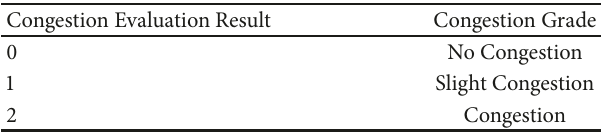
Table 4: Interpreting of evaluation result to road congestion grade. Congestion Evaluation